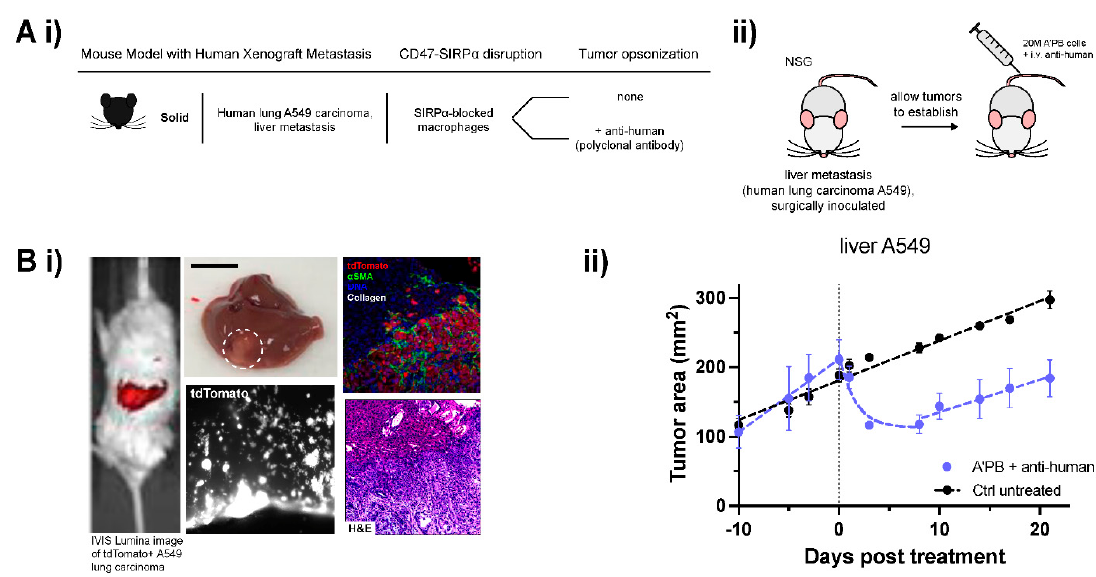
Figure 6. A’PB therapy represses growth in human metastatic WT CD47 tumors. ( A ) (i) Table of human xenograft mouse model details. Human lung A549 carcinoma is surgically implanted at an orthotopic metastatic site in the livers of NSG mice. Anti-SIRP α is used to block CD47 signaling on adoptively transferred marrow cells and anti-human is the source of tumor-opsonizing antibody (A’PB). (ii) Schematic of tumor induction and treatment. NSG mice were surgically implanted with liver metastases. Mice were treated with A’PB marrow on the indicated day 0, and 3 times weekly for 2 weeks with anti-human i.v. ( B ) (i) Representative whole-body fluorescence image of tdTomato signal in surgically implanted liver metastases (left). Images of explanted liver with liver metastasis (middle top, A549 tumor circled, scale: 1 cm) and tdTomato signal of A549s infiltrating stroma (middle bottom). (ii) Sectioned liver tissue images showing tdTomato, α SMA, DNA, and collagen of A549 metastases relative to normal liver tissue (top right) and H&E staining (bottom right). (ii) In vivo growth curve of liver metastatic human lung adenocarcinoma A549 tumors. A’PB and tumor- opsonizing antibody repress tumor growth by 50% over several days relative to untreated control. Tumor burden is monitored by fluorescent imaging with an IVIS Lumina II (fluorophore: tdTomato). Without additional treatment to continue tumor cell clearance, metastases begin to expand again after about 10 days. Error bars represent s.e.m. Exponential decay for Tumor area in the regression phase of the treated tumor fits to exp( − t/1.55) for 0 < t <